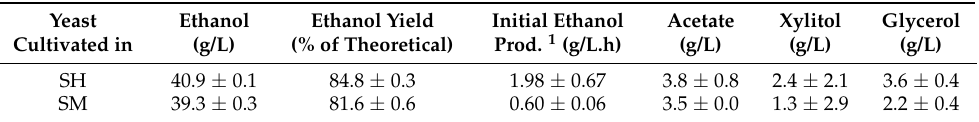
Figure 1. Metabolite concentration profiles from the SSF experiments. ( A ): ethanol ( ▲ ) and glucose ( ♦ ); ( B ): HMF (●) and furfural ( ■ ). Filled symbols and solid lines represent experiments with yeast cultivated on spruce hydrolysate. Empty symbols and dashed lines represent experiments with yeast cultivated on sugar medium. Duplicate experiments showed similar results and the figure shows one of the representative profiles for each cultivation. Table 2. Ethanol production and concentrations of metabolites obtained in the SSF experiments after 120 h with yeast cultivated in spruce hydrolysate (SH) and sugar medium (SM). The measurements are the average and standard deviation of two biological